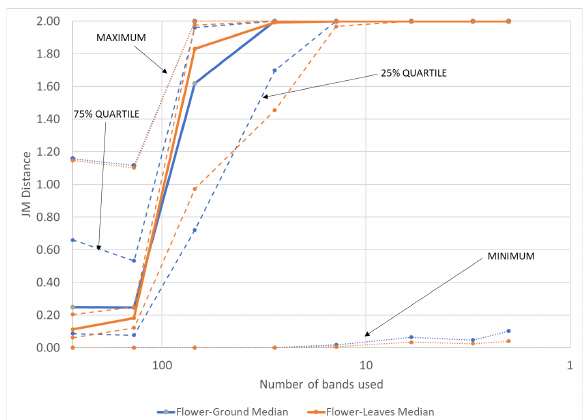
Figure 5. Number of spectral bands versus JM Distance values Using the median values as a reliable estimate of separability and a filter of median JM Distance > 1.9 for accurate classification (Vaiphasa, Ongsomwang et al. 2005), the top 10% of spectral bands from the ANOVA classification should be able to achieve reliable classification results between flowers and other objects (28 bands of wavelengths 476 – 566 nm).